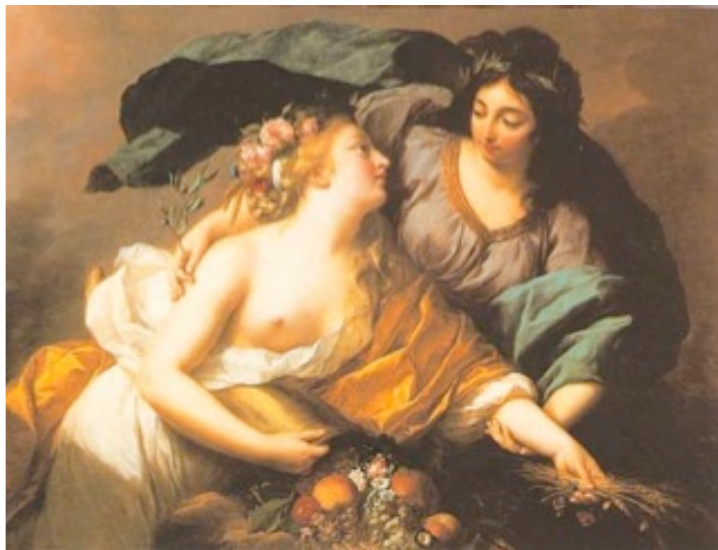
Fig. 5. Élisabeth-Louise Vigée-Lebrun, Peace Bringing Back Abundance, c. 1780. Oil on canvas, 104 x 132 cm. Musée du Louvre,